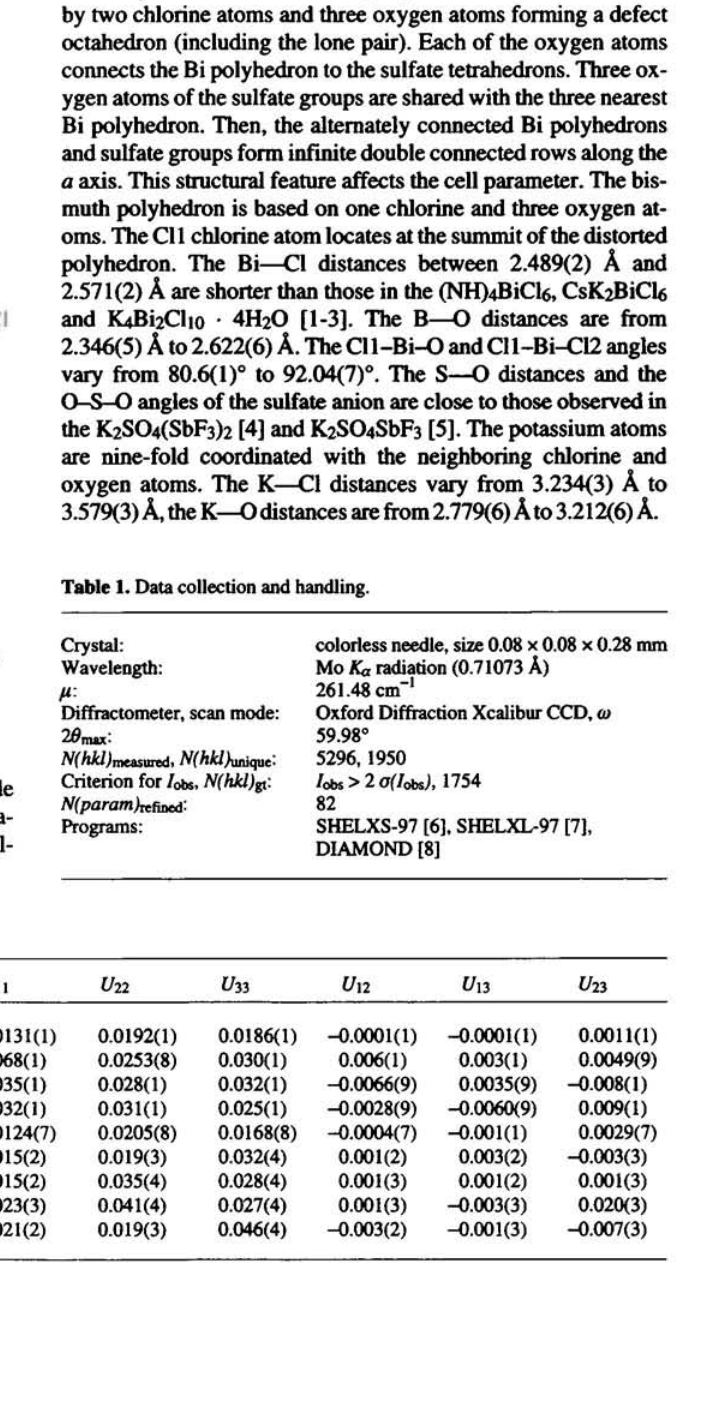
Table 2. Atomic coordinates and displacement parameters (in Â 2